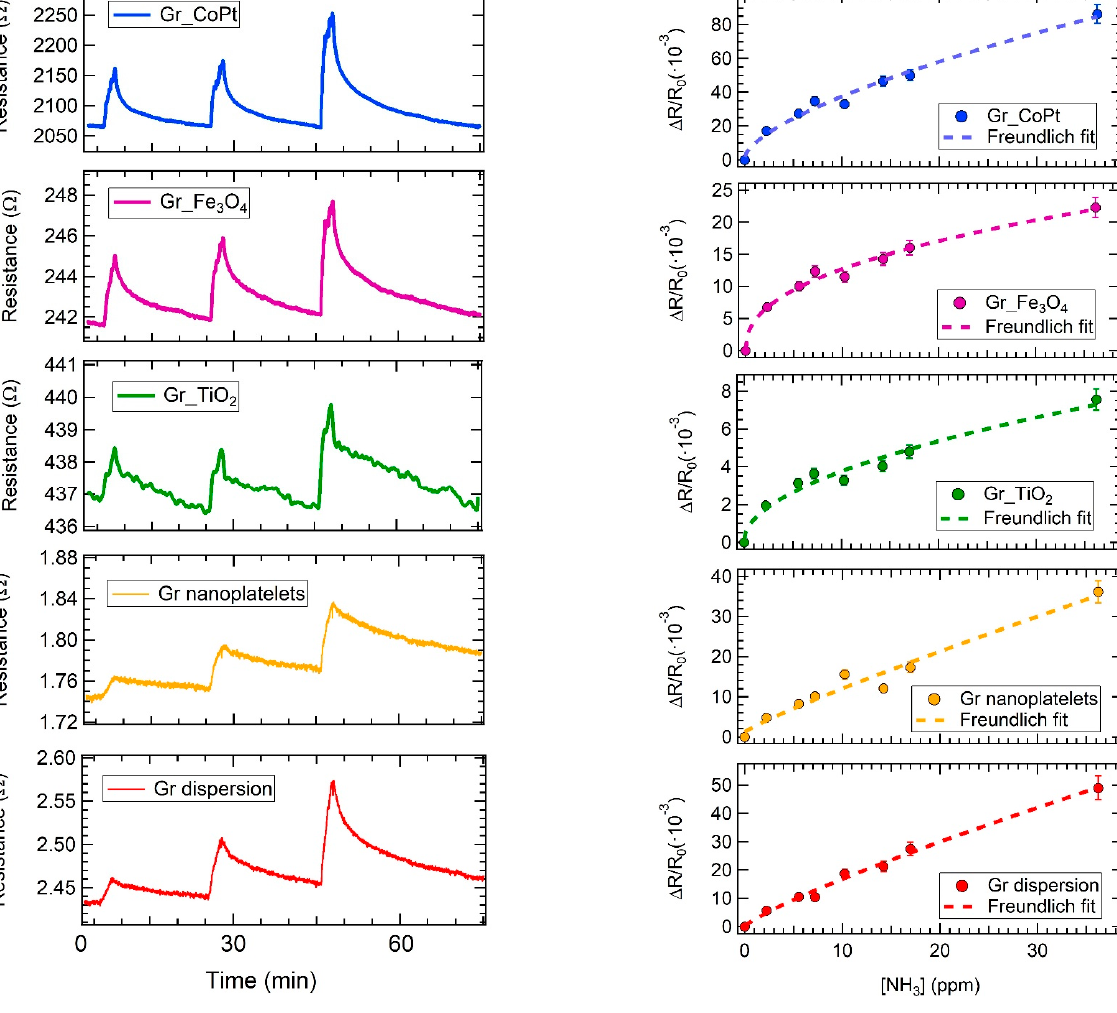
Figure 3. ( Left panel ): response of the sensor array to 14 ppm, 17 ppm, and 36 ppm ammonia exposures, respectively. ( Right panel ): calibration curves interpolated with a Freundlich fit; error bars represent standard deviation of the mean response obtained from three exposures to the same ammonia concentration.